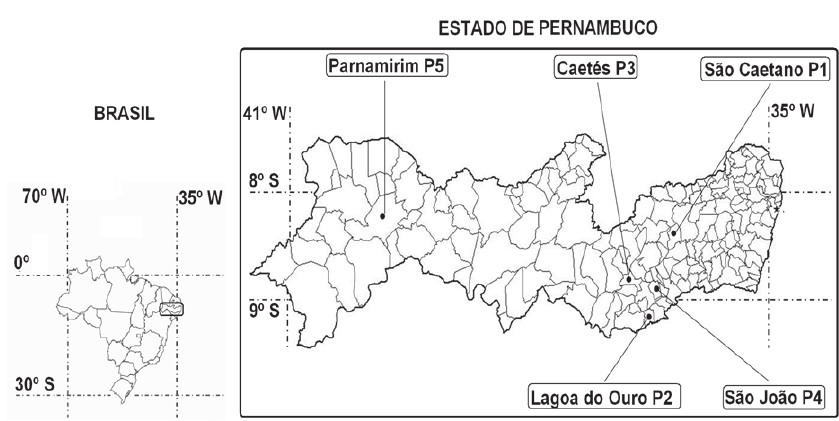
Figura 1. distribuição dos perfis ao longo do estado de Pernambuco.